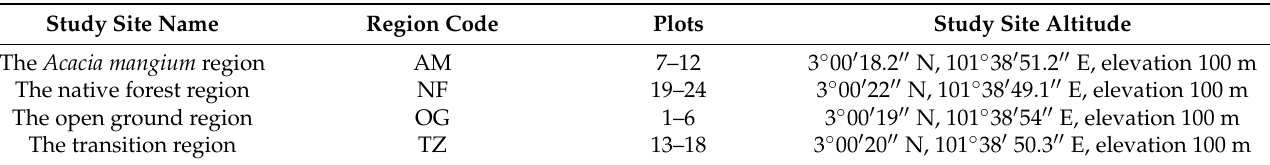
Table 1. Description of plot